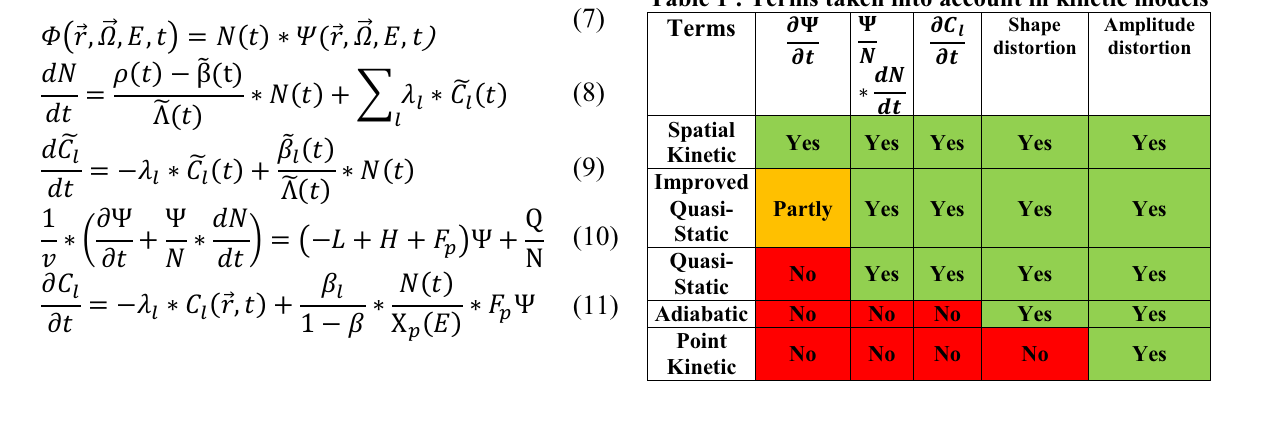
Table 1 : Terms taken into account in kinetic models